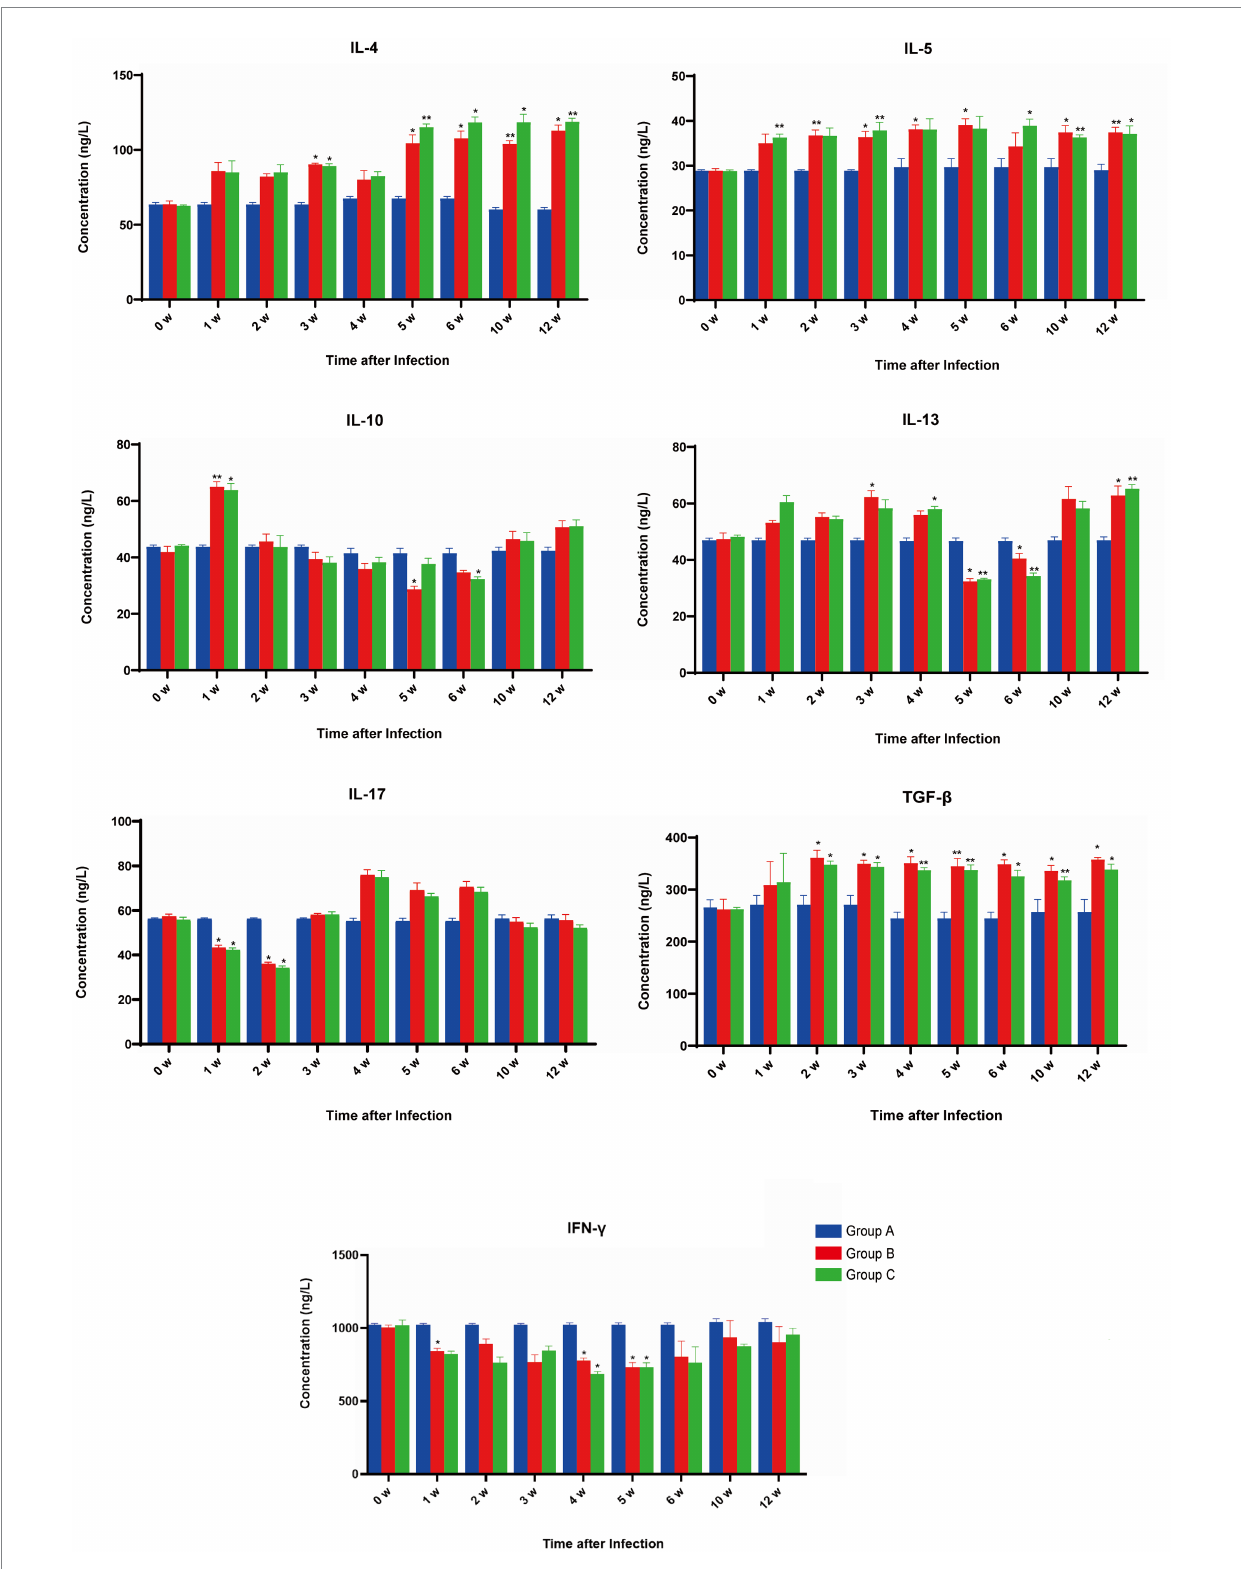
FIGURE 2 The effect of Fasciola gigantica on the levels of cytokine in the serum of primary and secondary experimentally infected buffaloes. The concentrations of seven cytokines were quantified pre-infection (week 0) and weekly after that for 8 weeks. Cytokine measurements were performed by ELISA kit and indicated in each panel. Bars represent the means ± SDs. Statistically significant (compared with pre-infection group) including p < 0.05 and p < 0.01 were indicated by asterisk (*) and (**)